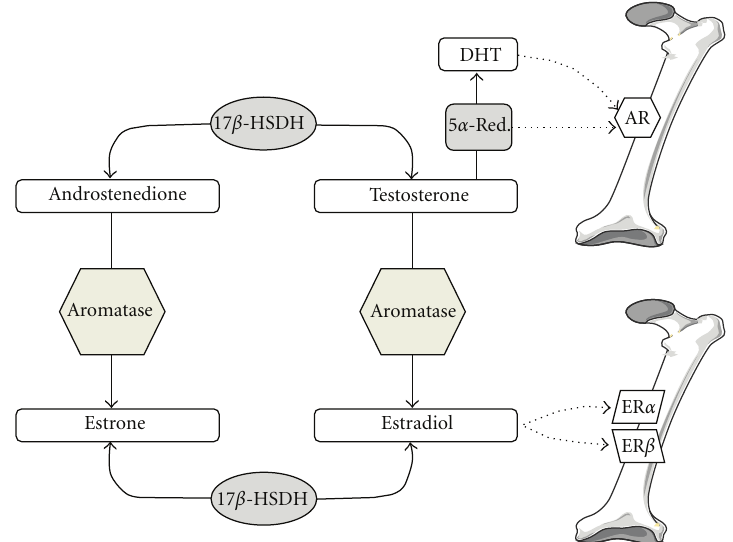
Figure 1: Proposed models of sex steroid hormones action on